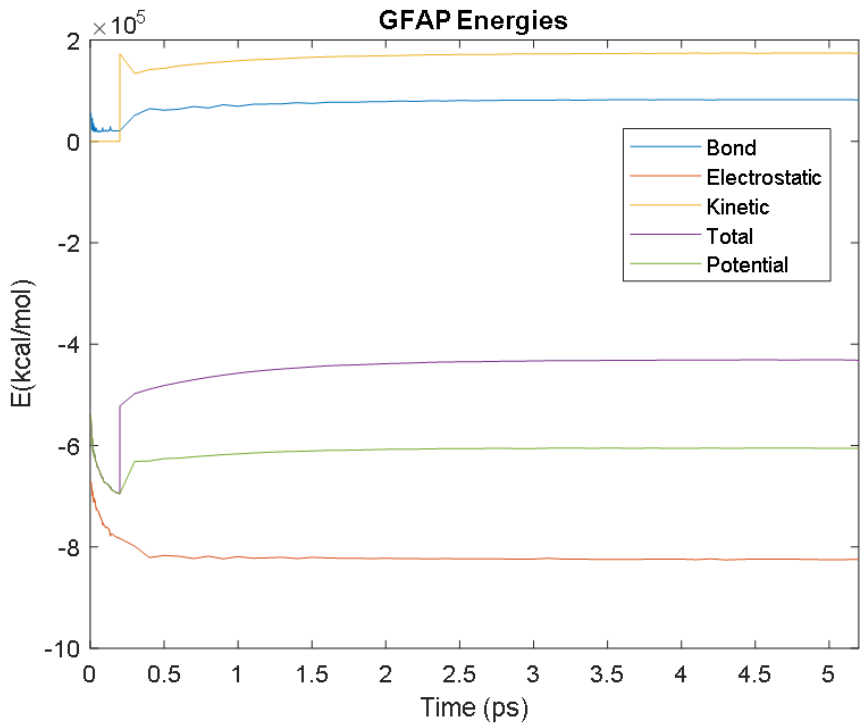
Figure 29. A plot of GFAP’s bond, electrostatic, kinetic, total, and potential energies.